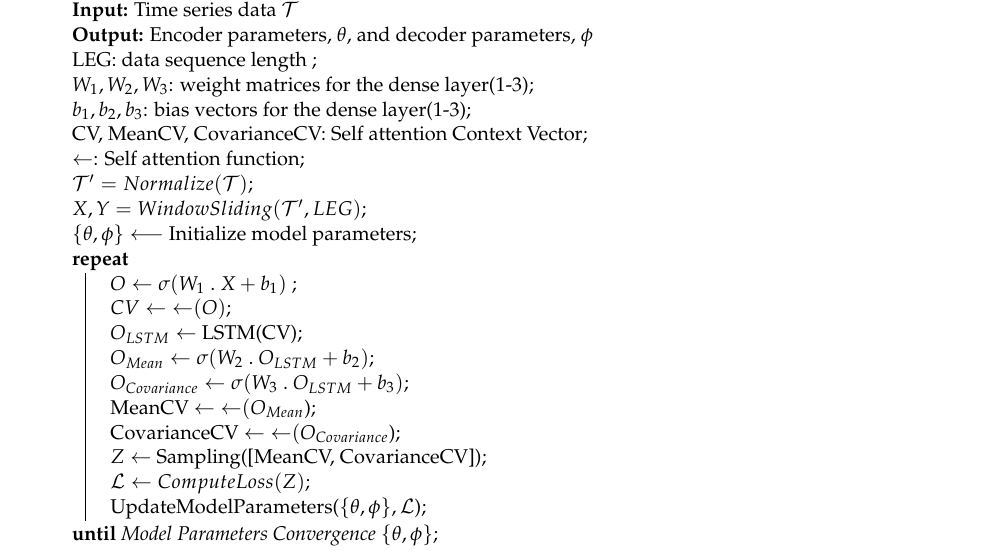
Algorithm 1: The training procedure of the GA-HD-VAE